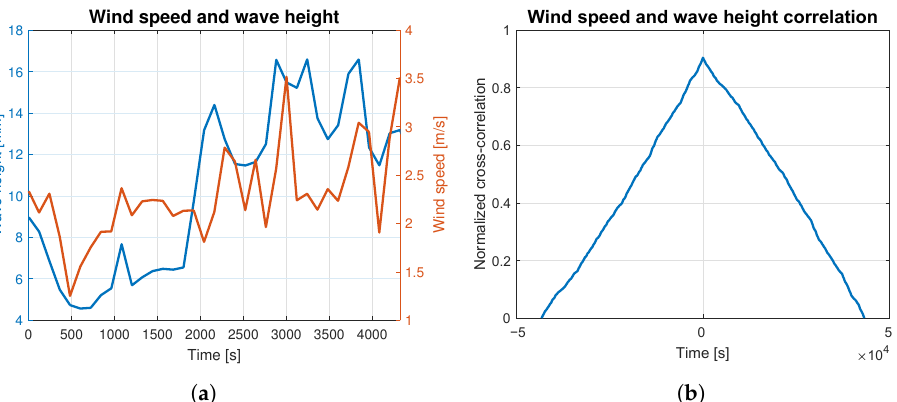
Figure 6. Wind speed and wave height correlation for 6 BFT: ( a ) wind speed and wave height measurements; ( b ) wind speed and wave height correlation.